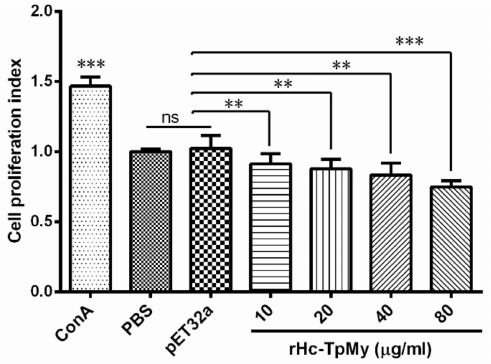
Figure 4. Influence of rHc-TpMy on PBMCs proliferation. Cells were stimulated with ConA and cultured with di ff erent concentrations of rHc-TpMy protein, pET32a protein or control bu ff er (PBS) at 37 ◦ C and 5% CO 2 . The proliferation assay was determined by CCK-8 incorporation after 72 h. PBMCs used for all replicates of distinct treatments in each experimental repetition were derived from the same goat. The data are presented as the mean ± SD and representative of triplicate experiments (** p < 0.01 and *** p < 0.001, ns: non-significant).